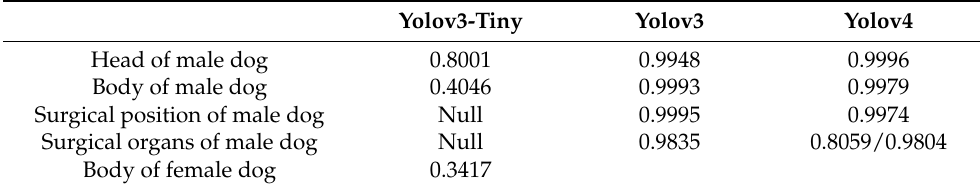
Figure 7. Pictures of the Yolov3-Tiny ( a ), Yolov3 ( b ) and Yolov4 ′ s ( c ) detection performance for Male Dog. Table 4. Detection performance for male dog.